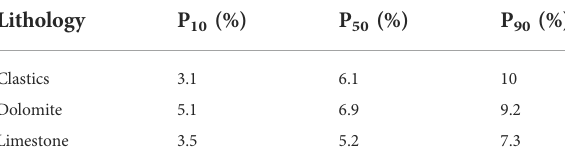
TABLE 3 Suggested values for geological storage coef fi cient for CO 2 in the saline